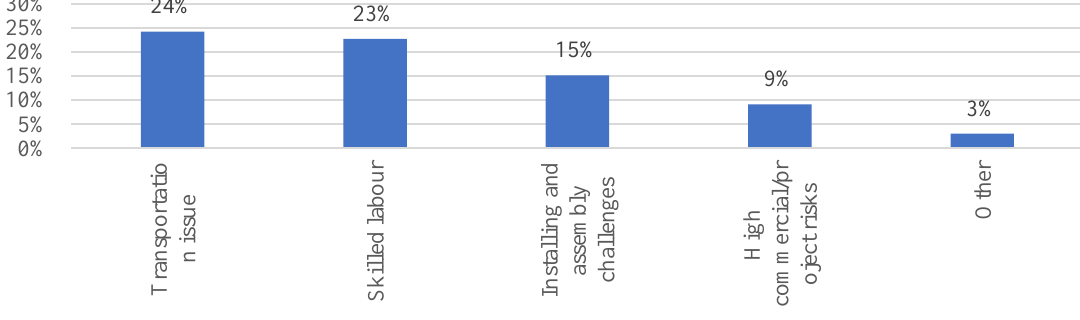
2.27: std dev = 0.86), and Opportunities of circular design (e.g., design for reuse/recycling) (mean = 2.13: std dev = 0.92). Supporting forestry and renewable sources 42% with a mean of 1.97 (std dev = 0.93) also features as a key opportunity.